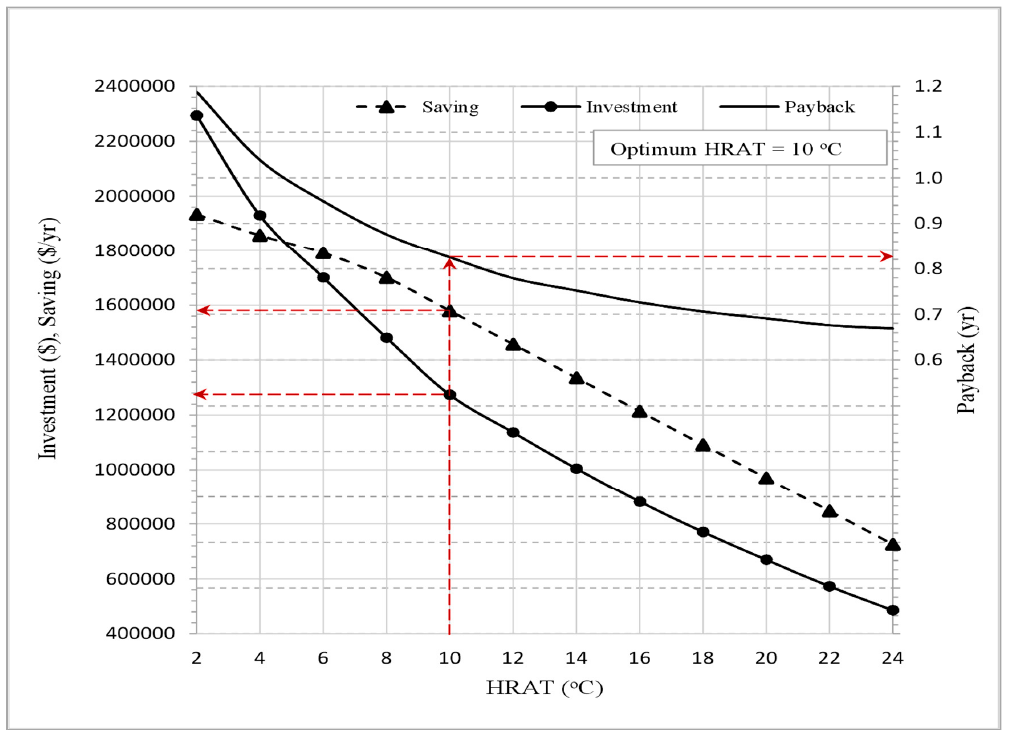
Figure 8. Investment, saving, and payback for option 3.